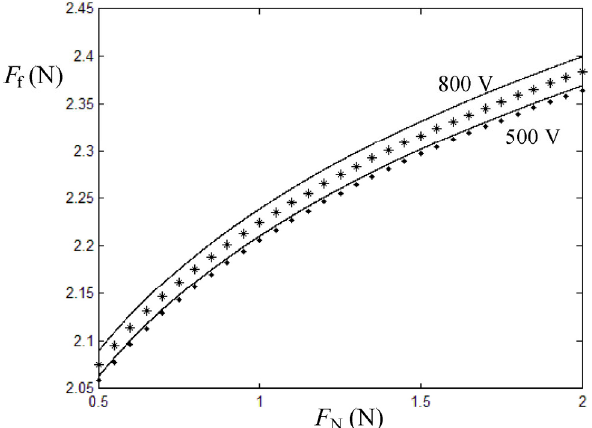
Fig. 4 Friction force F as a function of the normal force f p 0 5 2 N F for the wrist skin, with 10 MPa E and 0 N 10 kPa . The upper and lower solid curves are for the case where the surface roughness effect is included in the calculation of the average effective squeezing pressure with the voltages of 800 and 500 V, respectively. The asterisk and dotted curves correspond to the cases where the surface roughness effect is not included in the calculation of the average effective squeezing pressure with the voltages of 800 and 500 V, respectively.